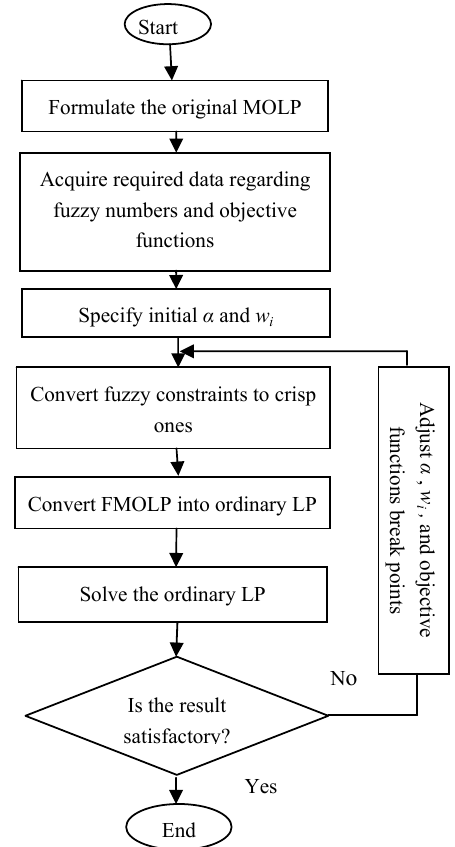
Fig. 4. Interactive procedure of solving